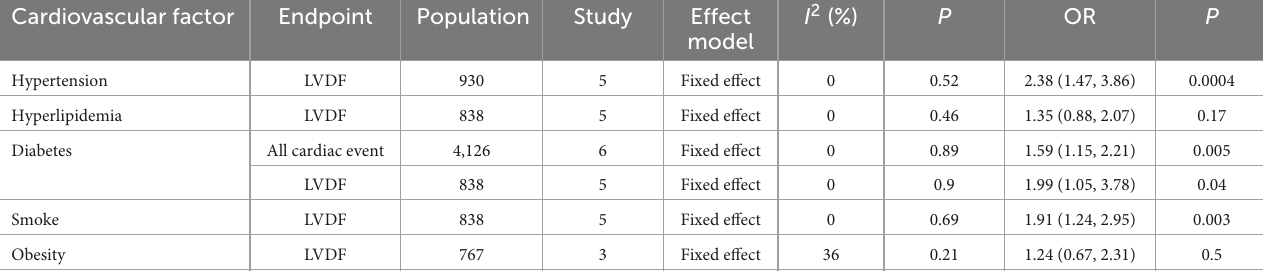
TABLE 2 Odds ratio of cardiovascular risk factor for anthracycline-induced cardiotoxicity. Cardiovascular factor Endpoint Population